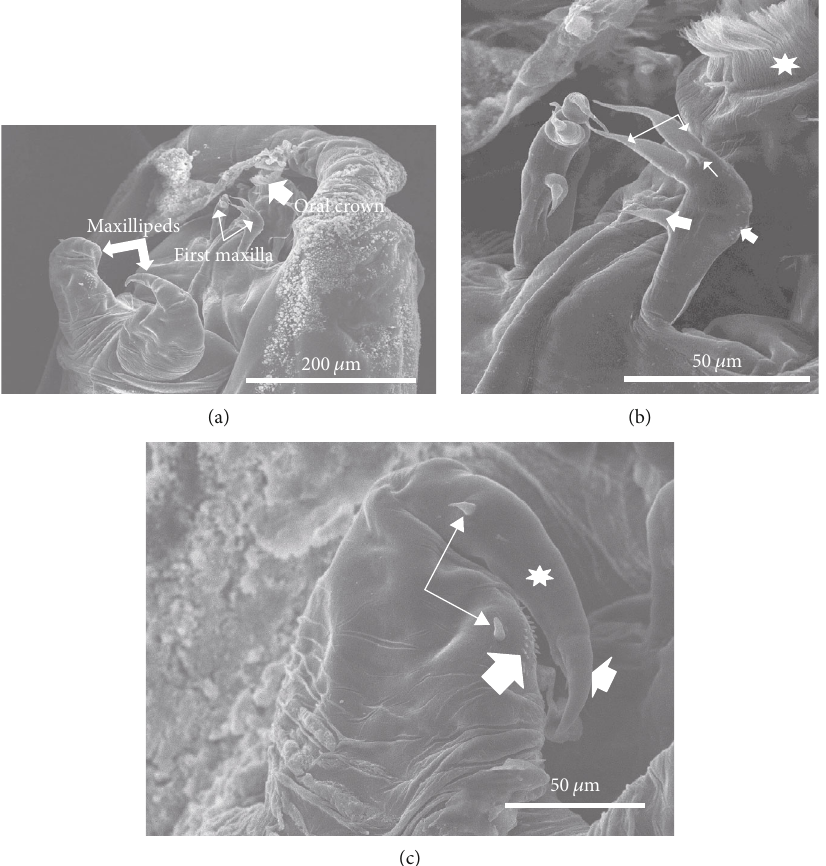
Figure 5: (a) Overall view of the anterior terminus of the cephalothorax including the mouth parts (2 nd maxillipeds (large arrows), 1 st maxilla (small arrows), and oral crown with apical setae (large arrowhead)). (b) Detail of the 1 st maxillae. Note endopod and exopod with long slender spines and situated at the apex (large arrows). Large arrowhead indicates a short palp with primary and secondary spines. Note short stout spine at the base of the exopod (small arrow) near small patches of spicules (small arrowhead). Star indicates oral setae. (c) Maxilliped with larger jointed subchela (star) with claw and pincers (small arrowhead). Note short robust spines (arrows) and small ornamental denticles (large